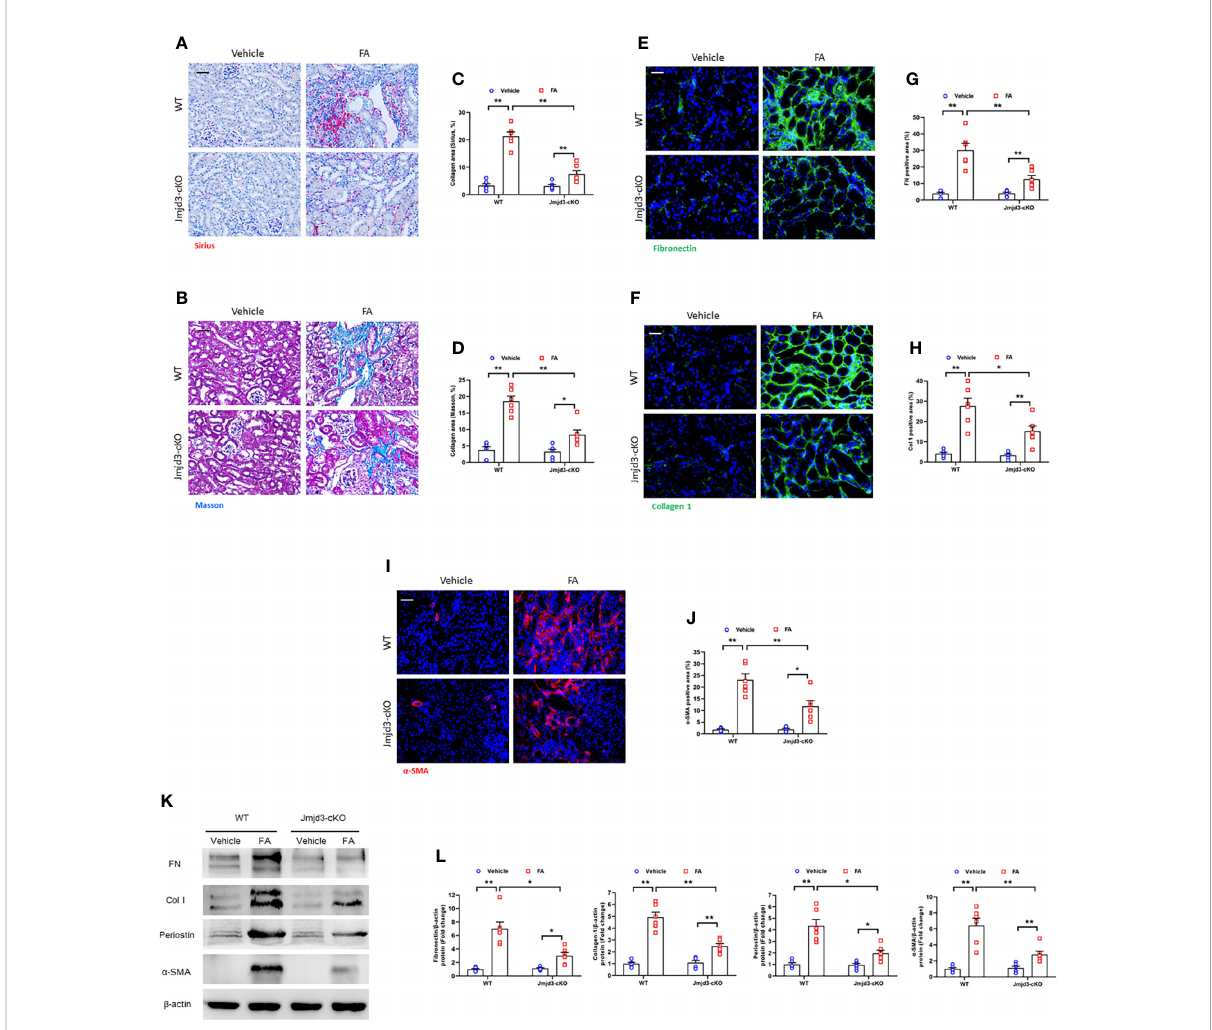
FIGURE 3 Myeloid Jmjd3 deletion suppresses renal fi brosis, extracellular matrix protein expression, and myo fi broblasts accumulation in kidneys with FA injury. (A, B) Kidney sections were stained with Sirius red or Masson ’ s Trichrome reagent. (C, D) Quantitative analysis of collagen area of each group. (E, F) Kidney sections were stained for fi bronectin (green) or collagen I (green). (G, H) Quantitative analysis of fi bronectin or collagen I- positive area. (I) Kidney sections were stained for a -SMA (red). (J) Quantitative analysis of a -SMA -positive area in the kidneys. (K) Western blots bands of protein expression of fi bronectin, collagen I, periostin and a -SMA in the kidneys. (L) Quantitative analysis of proteins levels in the kidneys. * P <0.05 or ** P <0.01; n=6; Bar = 50 m m. WT, wild-type; cKO, conditional